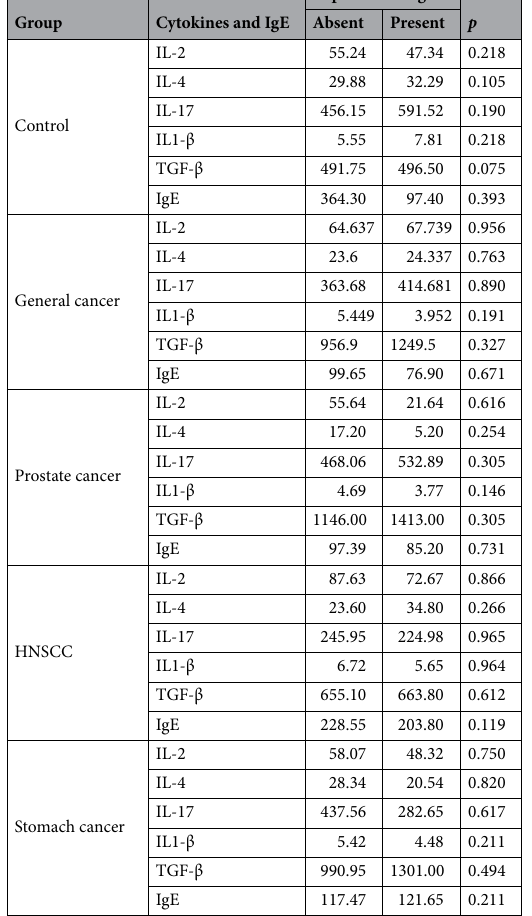
Table 4. Cytokine (pg/ml) and IgE (UI/ml) values among the groups and reported allergies. Kruskal– Wallis Test. Groups: Control (n = 20) and General Cancer (n = 60), that was the sum of three subgroups: Prostate (n = 20), HNSCC (n = 20), and Stomach (n = 20) Cancer. Abbreviations: IgE = immunoglobulin E, IL = interleukin, TGF = transforming growth factor, HNSCC = head and neck squamous cell